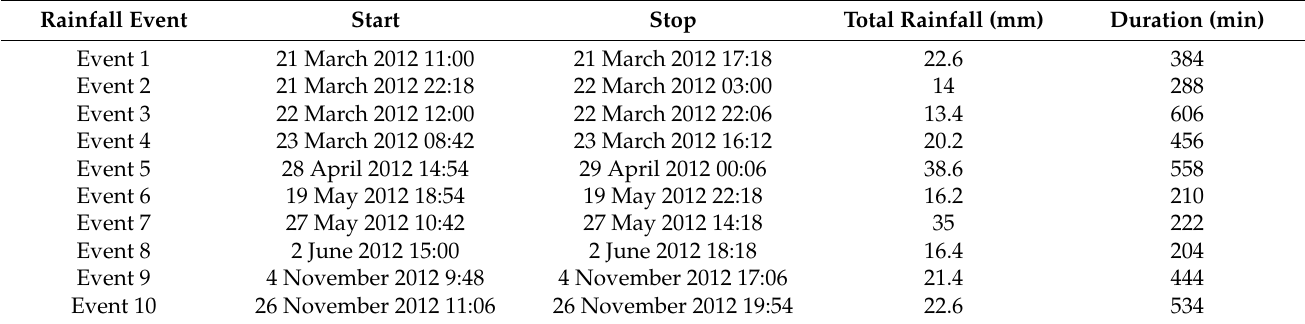
Table 1. Events occurred in Encamp during 2012